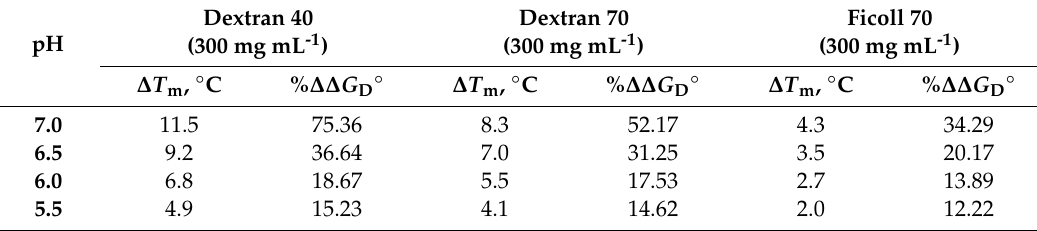
Table 3. Changes in stability parameters on transferring α -LA from 0 mg mL − 1 to 300 mg mL − 1 of crowding agents and their comparison at di ff erent pH values a,b